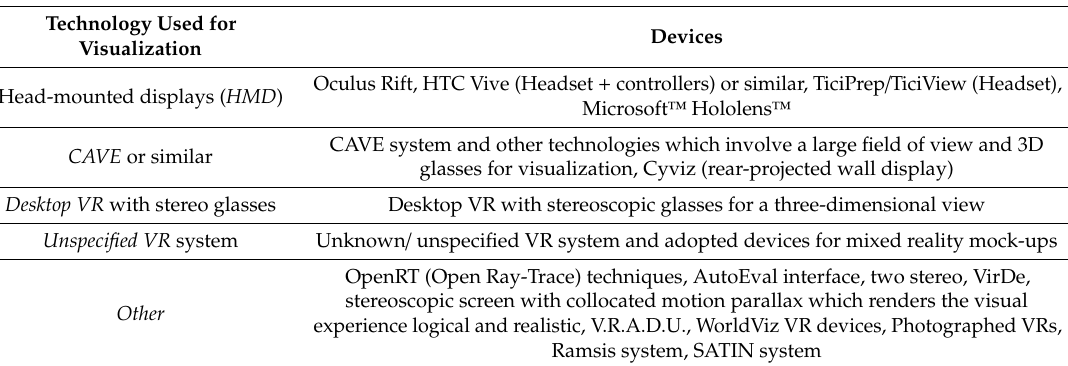
Table 3. Categories of VR technologies